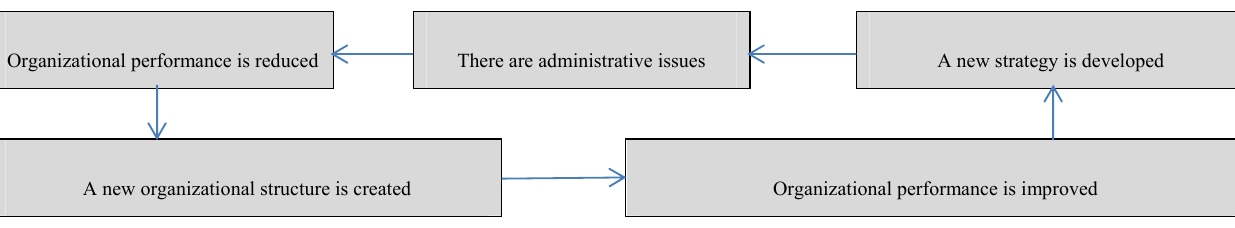
Fig. 2. The relationship between structure and strategy based on the study by Chandler (David,